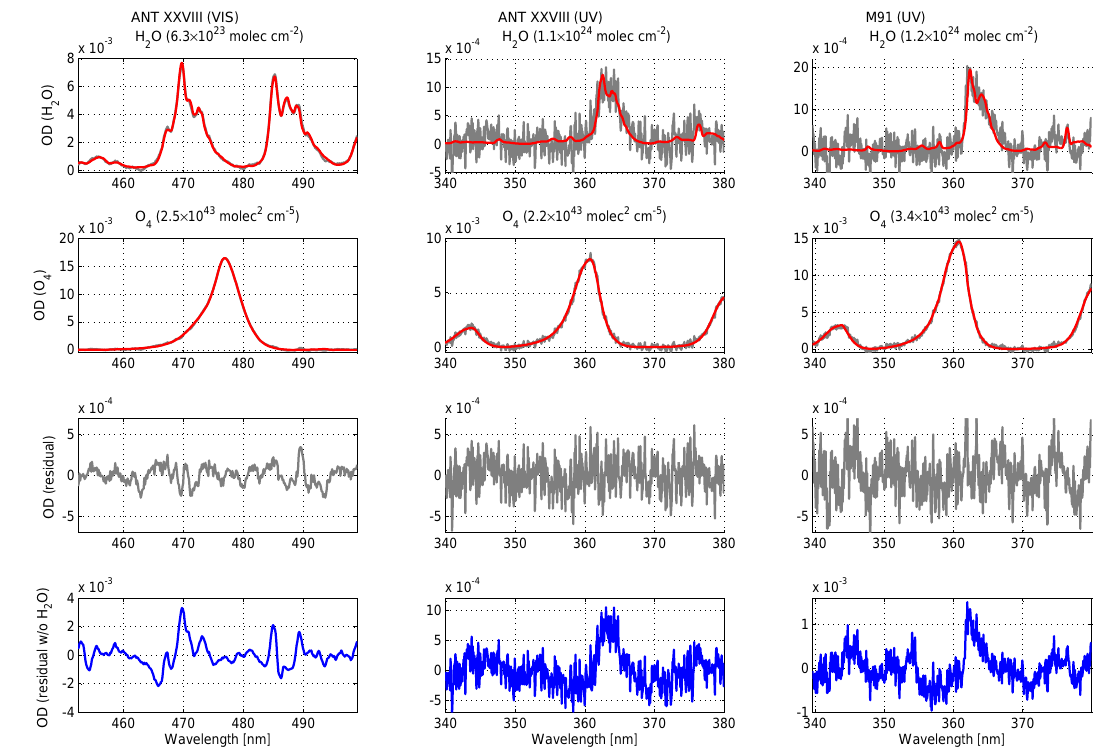
Figure 5. Fit results from ANT XXVIII/1-2 and M91 showing the detection of water vapour absorptions at 477 and 363nm; in red, the modelled absorptions according to the cross sections listed in Table 2; in grey, the measured values. In blue, the residual is shown if no water vapour absorption was included in the fit. The fits from ANT XXVIII/1-2 use a spectrum (exposure time: 120s; spectral resolution: 0.7nm) from 16 November 2011 at 13:20UTC at 3 ◦ 59 (cid:48) 06 (cid:48)(cid:48) N, 14 ◦ 44 (cid:48) 40 (cid:48)(cid:48) W at a telescope elevation angle of 3 ◦ . At 477nm the O 4 dSCD is ( 2 . 47 ± 0 . 01 ) × 10 43 molec 2 cm − 5 and the H 2 O dSCD ( 6 . 27 ± 0 . 06 ) × 10 23 moleccm − 2 . At 360nm the O 4 dSCD is ( 2 . 18 ± 0 . 04 )